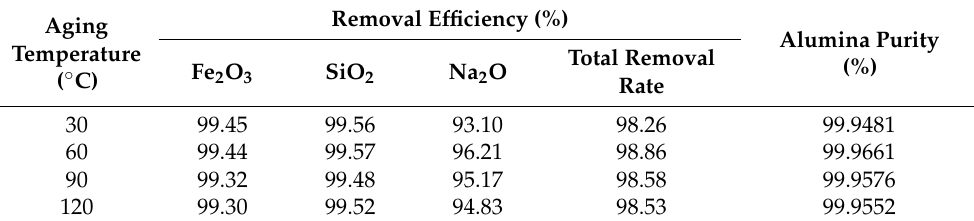
Table 4. Influence of aging temperature on impurity removal efficiency and alumina purity.